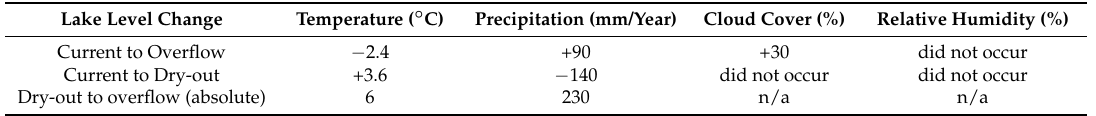
Table 4. Changes in parameter leading to overflow or dry-out from the present lake level. Lake Level Change Temperature ( ◦ C) Precipitation (mm/Year) Cloud Cover (%) Relative Humidity (%) Current to Overflow − 2.4 +90 +30 did not occur Current to Dry-out +3.6 − 140 did not occur did not occur Dry-out to overflow (absolute) 6 230 n/a